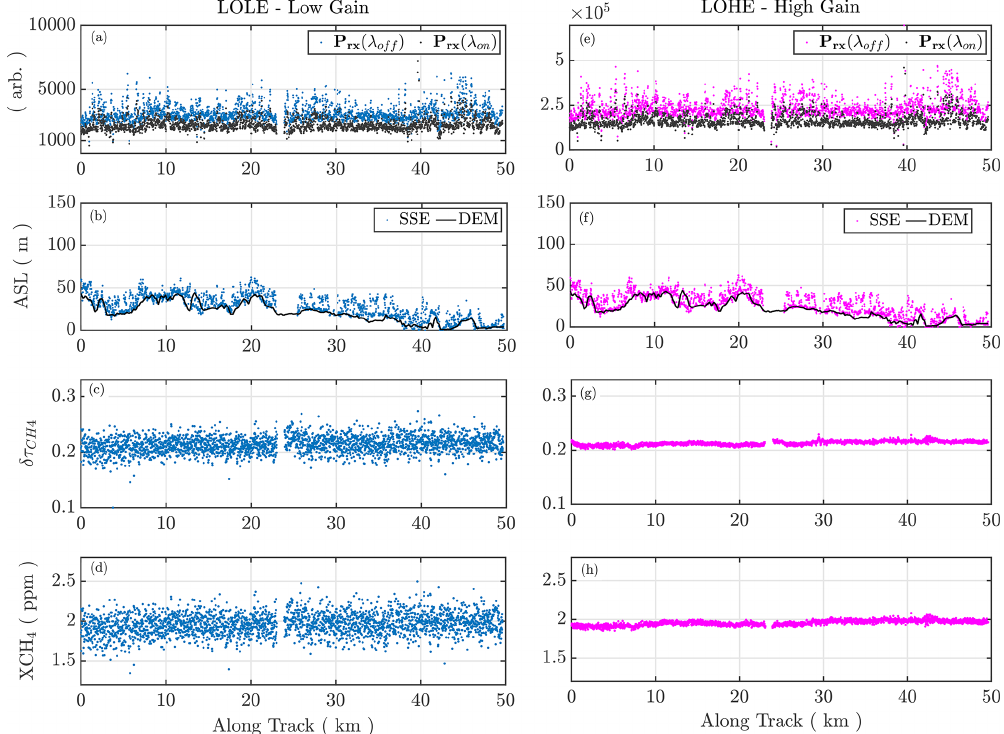
Figure 7. Example from the 11 June flight (3200ma.g.l.) of the macroscopic processing steps involved in retrieving the column XCH 4 for a 50km along-track segment at 2Hz with the low-gain and high-gain channels shown on the left (a–d) and right (e–i) , respectively. Panels (a) and (e) show the integrated ground return signals. Panels (b ) and (f) show the calculated SSE and DEM. Panels (c) and (g) show the calculated DAOD reported at 2Hz intervals. Panels (d) and (h) show the final retrieved XCH 4 at 2Hz.